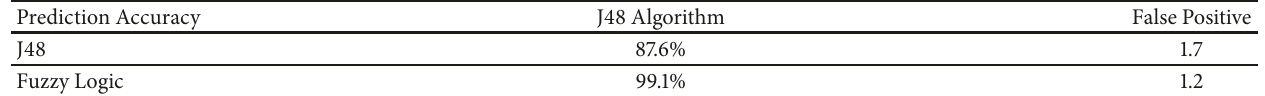
Table 3: Predictive accuracies of fuzzy logic with J48 for soil